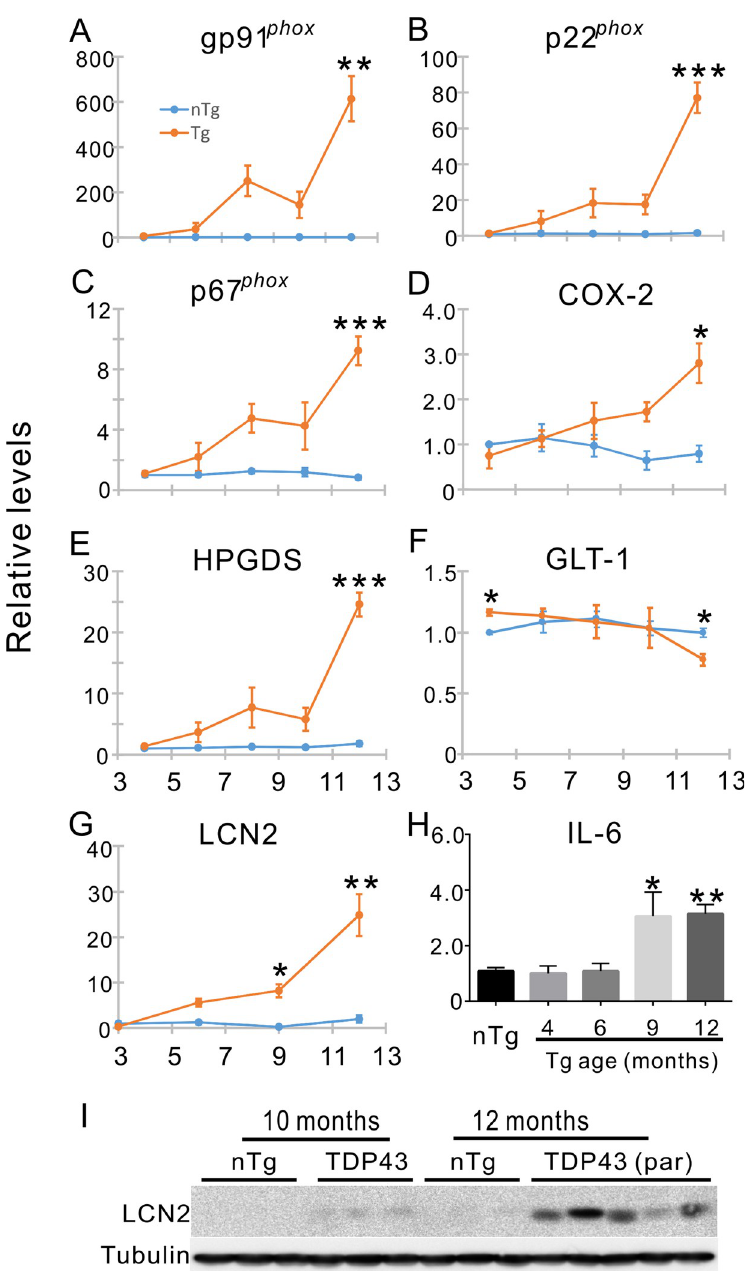
Fig 10. Age-dependent alterations in the expression of neuroinflammatory markers. (A-C) A dramatic increase in subunits of NADPH oxidase 2 (Nox2) gp91phox, p22, and p67 mRNA expression in late stages of motor dysfunction in the Tg mice. (D, E) Increased mRNA expression of prostaglandin-producing enzymes cyclooxygenase 2 (COX-2 or PTGS2) and hematopoietic prostaglandin D synthase (HPGDS), respectively. (F) Decreased expression of GLT-1 mRNA. (G, I) Increased expression of lipocalin 2 (LCN2) mRNA and protein, respectively. (H) Increased expression of IL-6 mRNA. Student t tests with Bonferroni correction were used to compare between the Tg and the nTg mice at different ages in (A-H). n = 3–8 at each age for both Tg and nTg groups. � p < 0.05, �� p < 0.01, ��� p < 0.001.